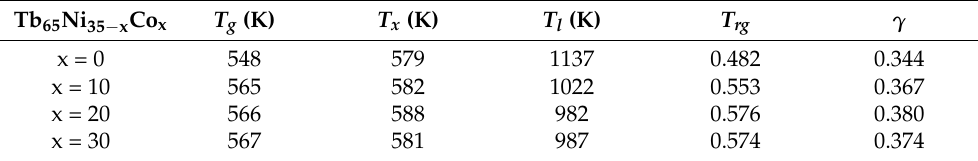
Table 1. Thermal parameters, T rg and γ of the Tb 65 Ni 35 − x Co x (x = 0, 10, 20 and 30) amorphous alloys.